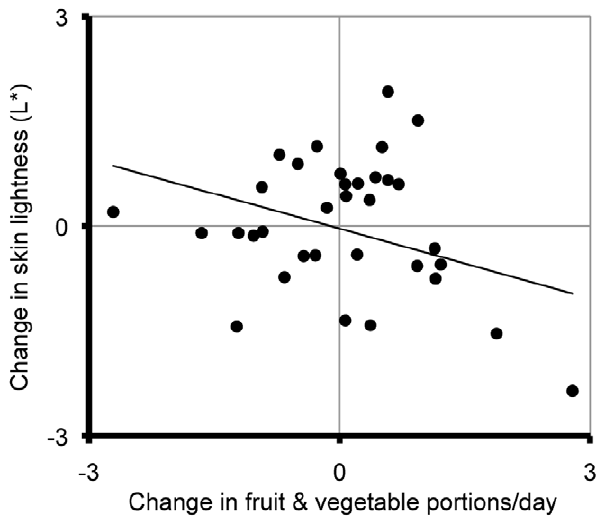
Figure 1. The relationship between six-week changes in fruit and vegetable intake and average skin lightness (L*).